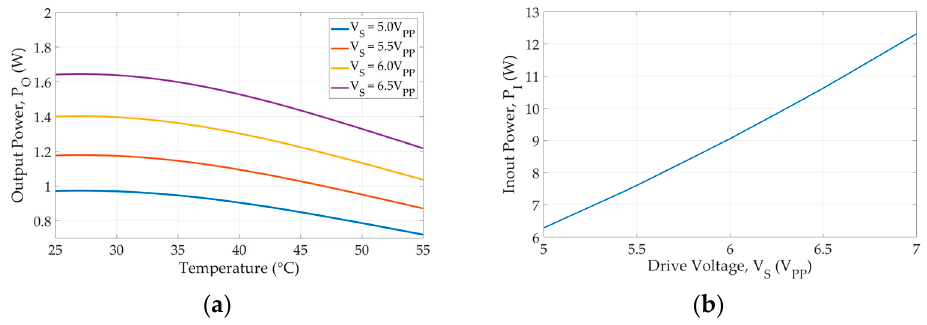
Figure 7. ( a ) The variation in the output power when the load R L = 300 Ω in different temperatures, and ( b ) the input power variation in the case of the driving voltage increment for fixed load in R L = 300 Ω .